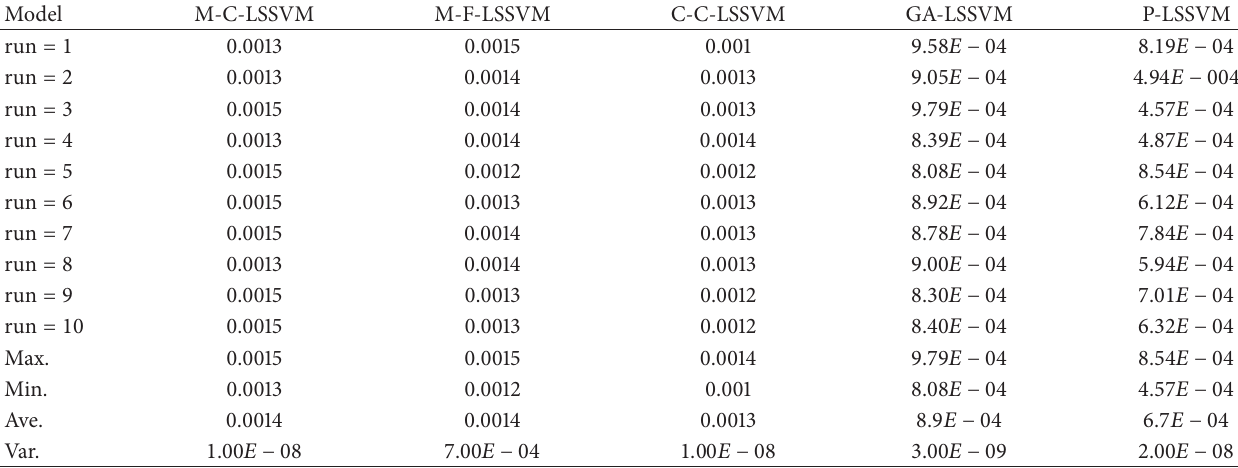
Table 5: Five models predicted error based on MAPE for FM broadcasting